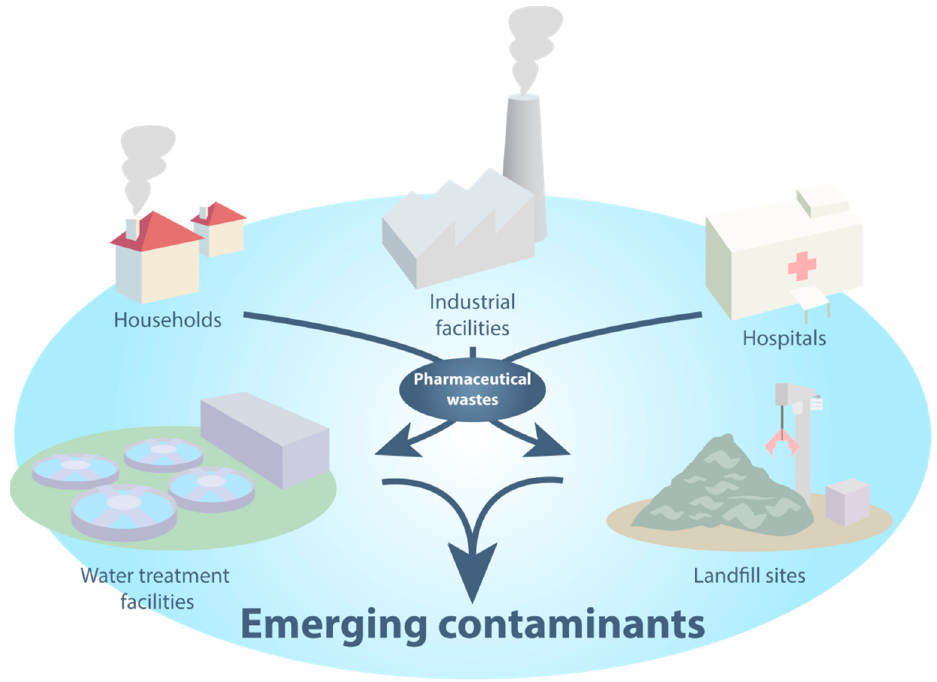
Figure 1. Schematic representation of sources of emerging contaminants.